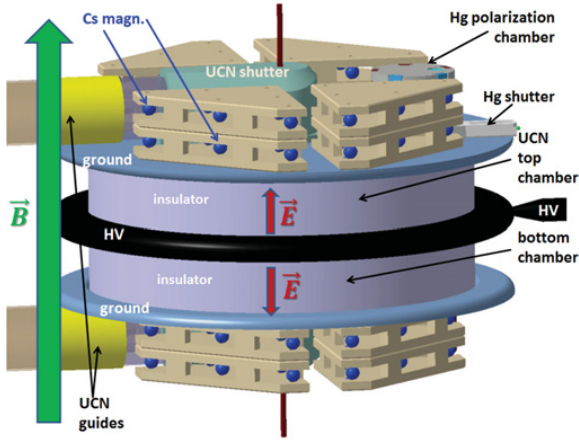
Figure 2. Double chamber design. The center electrode is at high voltage while the two outer electrodes are grounded. Both UCN chambers will also contain polarized Hg atoms used as a co-magnetometer. An array of Cs magnetometers will surround the top and bottom electrodes. This entire setup will be placed in a uniform magnetic field of 1 µ